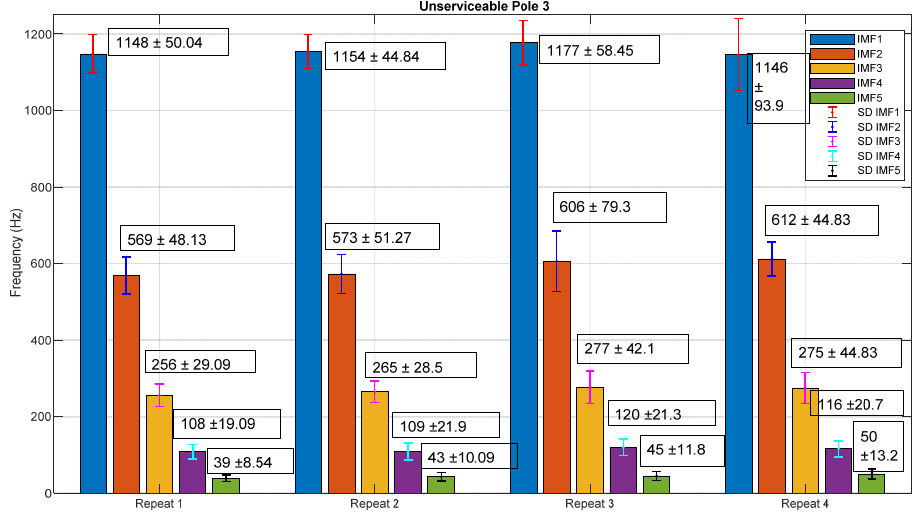
Figure 18. Bar chart showing frequency range of dominant IMFs, average frequency of each IMF and standard deviation for 12 accelerometers, Serviceable Pole 1.